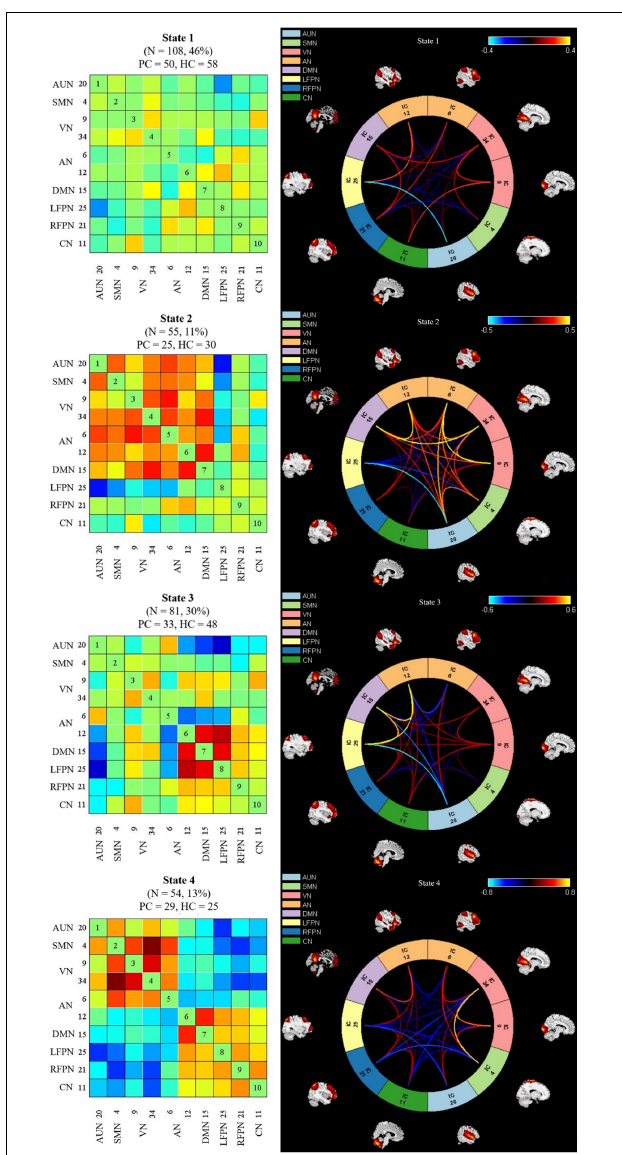
FIGURE 4 | Left column indicates dynamic functional network connectivity (dFNC) centroids of the four states, the number of subjects, and the percentage of occurrence in each state. Right column shows the visualization of dFNC in each state. PC, presbycusis; HC, healthy controls; AUN, auditory network; SMN, sensorimotor network; VN, visual network; LFPN, left frontoparietal network; RFPN, right frontoparietal network; DMN, default mode network; AN, attention network; CN, cerebellum network.